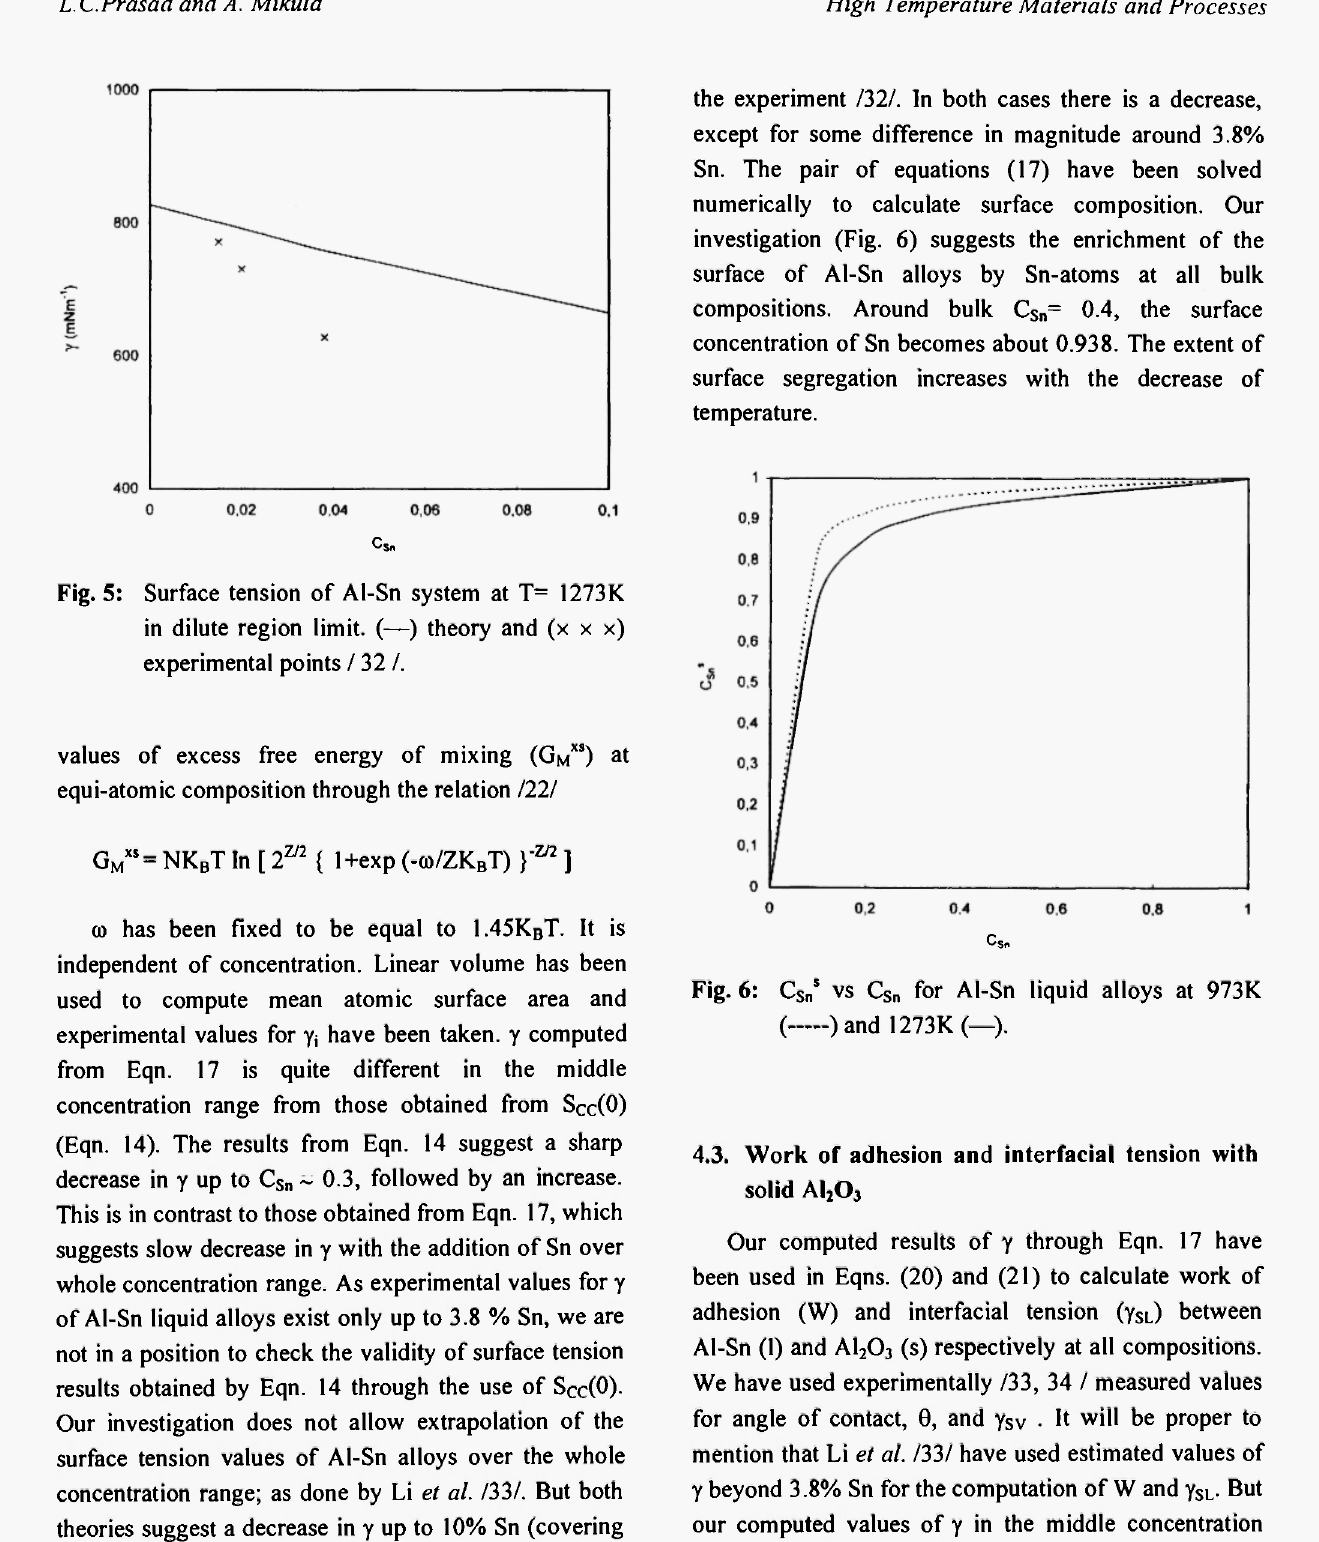
Fig. 5: Surface tension of Al-Sn system at T= 1273K in dilute region limit. (—) theory and (χ χ χ) experimental points / 32 /.